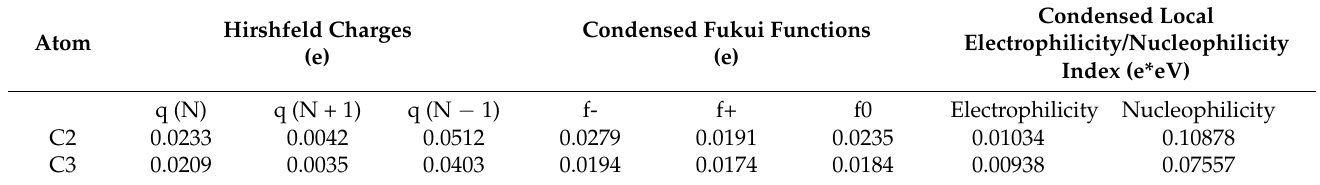
Table 2. Activity descriptors of C2 and C3 atoms for E64 inhibitors calculated by density functional